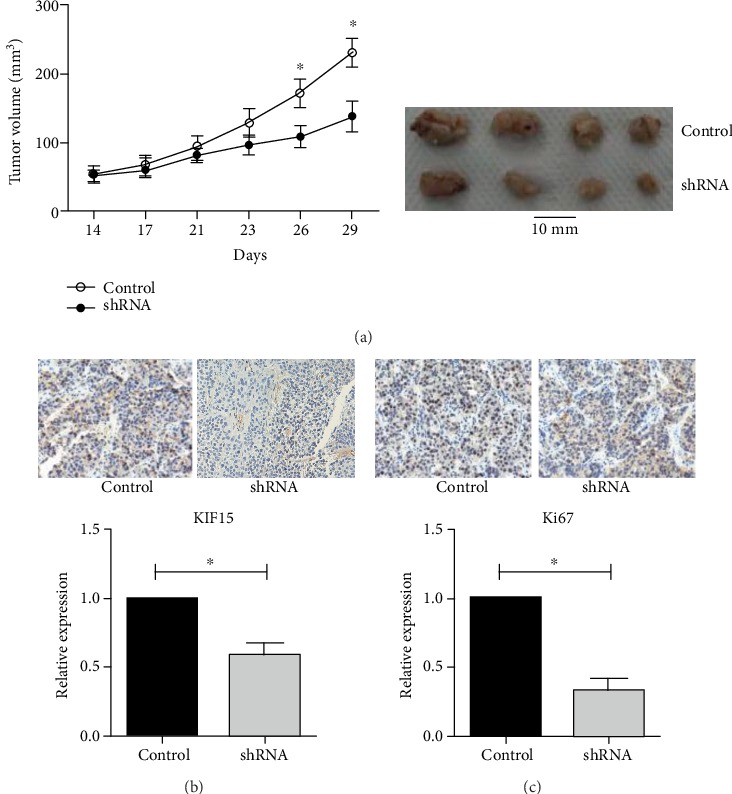
KIF15 facilitated HCC growth in mice. (a) Hep3B cells infected with control or KIF15 shRNA lentivirus were subcutaneously implanted into nude mice. After 2 weeks, tumors were isolated, and volume was examined every 3 days (n = 4 in each group). Tumor growth curve was calculated and analyzed according to the average volume of 4 tumors in each group. (b) IHC assays indicated the expression level of KIF15 in control or KIF15 depletion tumor tissues isolated from mice. (c) IHC assays revealed the expression level of Ki67 in control or KIF15 depletion tumor tissues taken from mice. Results are presented as mean ± SD, ∗P < 0.05.